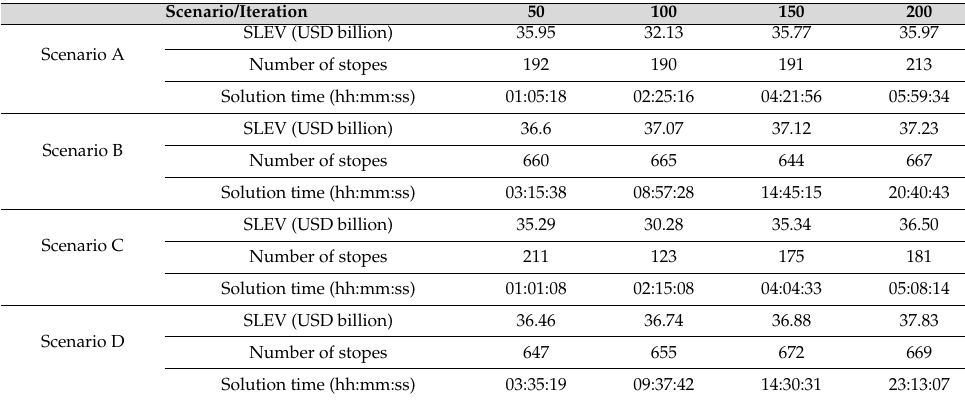
Table 6. Summary of DIA performance